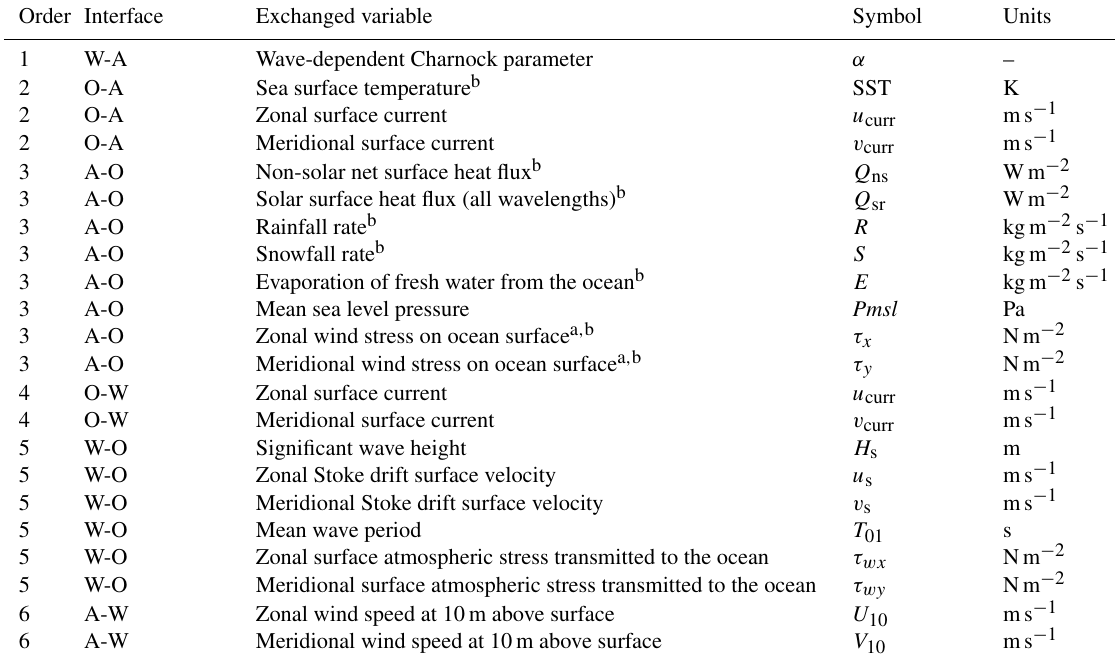
Table 3. Summary of the coupling exchanges between atmosphere/land (A), ocean (O), and wave (W) components within the RCS-IND1 regional coupled configuration. The fields marked with a are only exchanged in atmosphere/land–ocean coupled configurations. Only the fields marked with b are exchanged in atmosphere/land–KPP ocean coupled configurations.